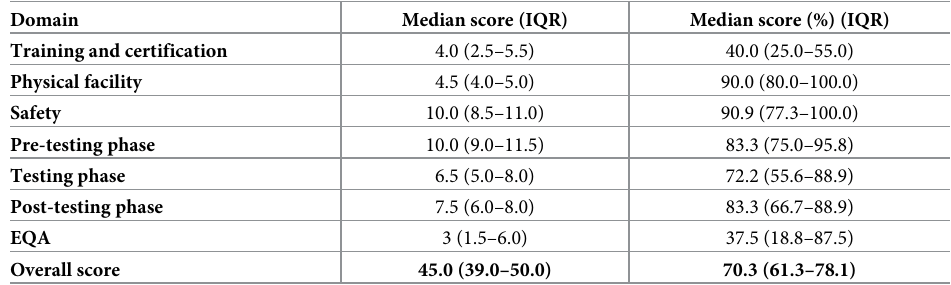
Table 2. Distribution of median scores and percentage scores by domain among sites assessed in round one (N = 1,915), between 18 th of April 2015 to 13 th of December 2017, SPI-RT assessment, South Africa.